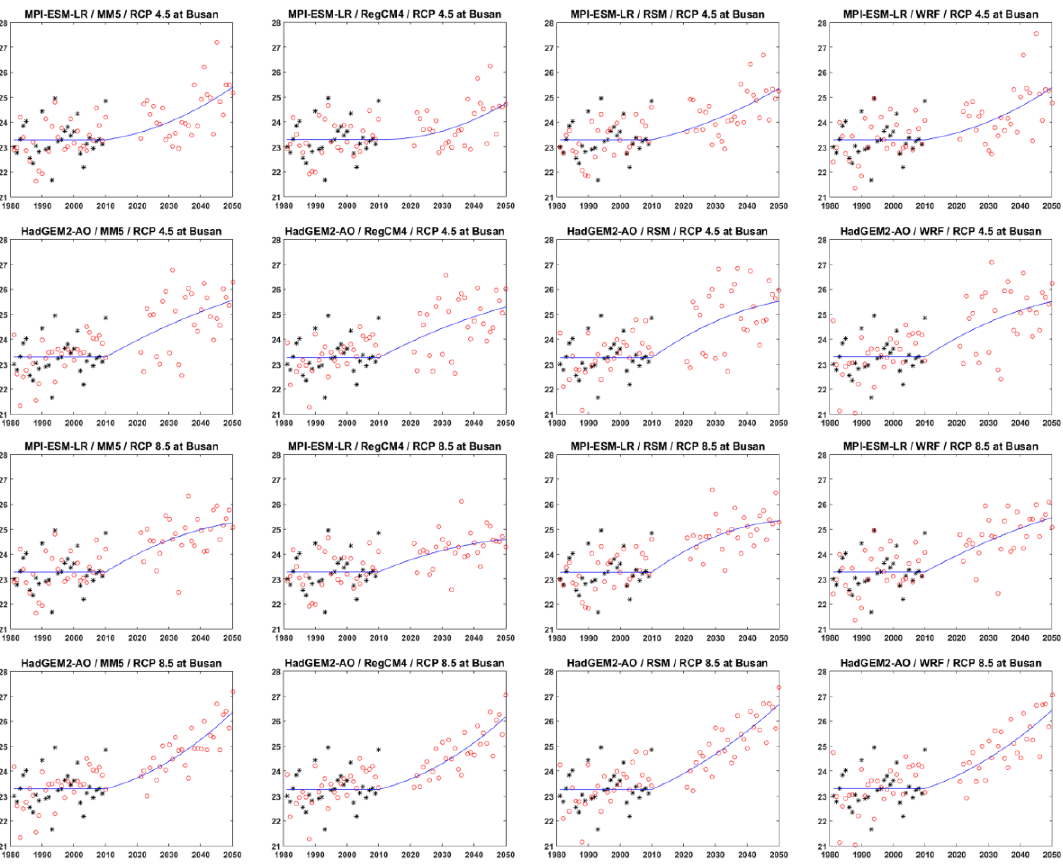
Figure 9. Yearly SAT time series at Busan site.